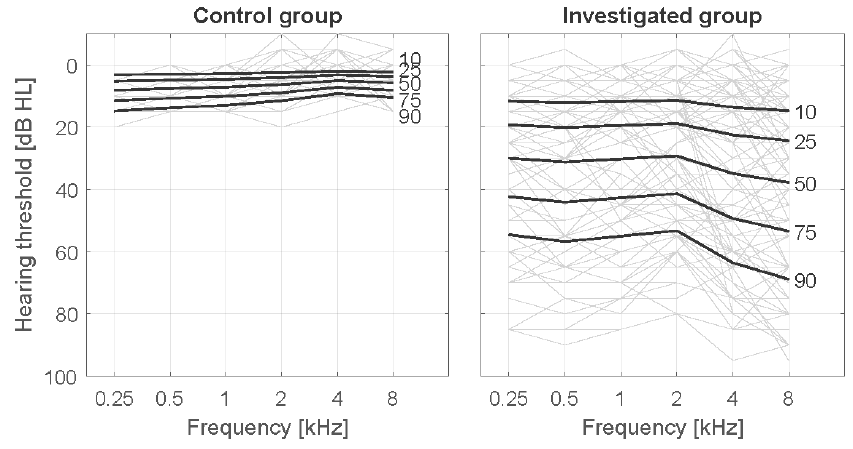
Figure 2. Air conduction hearing thresholds in the control group and in the investigated group. Table 2. Types of hearing loss in study groups.